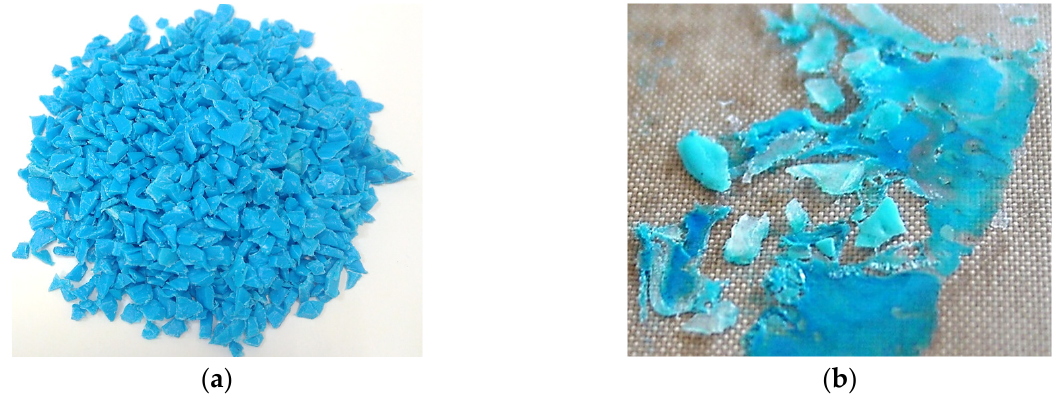
Figure 4. PEX waste particles: ( a ) Before being heated; ( b ) After applying heat and pressure at 180 °C.